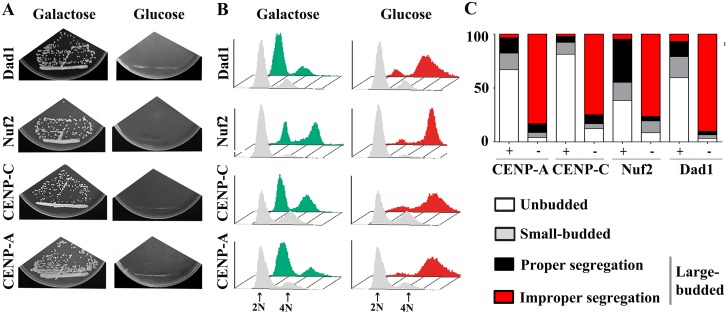
Depletion of conserved kinetochore proteins causes chromosome mis-segregation in C. tropicalis.(A) CENP-A, CENP-C, Nuf2 and Dad1 are essential for viability in C. tropicalis. C. tropicalis conditional mutant strains expressing the only copy of the above mentioned genes under the GAL1 promoter were streaked on plates with galactose (permissive) or glucose (restrictive) as the sole carbon source and were photographed after 2 to 3 days of incubation at 30°C. The GAL1 promoter is induced in the presence of galactose but repressed in glucose containing media in C. tropicalis. (B) FACS analysis of the conditional mutant strains of CENP-A, CENP-C, Nuf2 and Dad1 grown in either permissive (galactose), or non-permissive (glucose) media. The x-axis and y-axis represent the DNA content and number of cells respectively. (C) The distribution of unbudded, small-budded and large-budded (G2/M stage) cells of indicated mutant strains grown in either permissive (+) or non-permissive (-) conditions. The nuclear morphology was visualized by DAPI staining after 6 h of growth in permissive or non-permissive condition and the cells exhibiting proper or improper chromosome segregation during the G2/M stage are counted (n = >250 cells). The y-axis represents the percentage cell population.